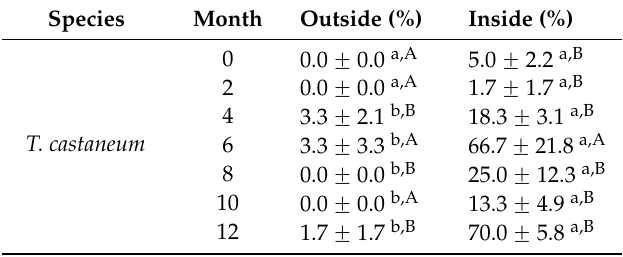
Table 1. Percentage (mean ˘ SE) of adult emergence of 4-week old larvae of T. castaneum and T. confusum exposed on the outside and inside surfaces of methoprene-treated bags (0.1% active ingredient). Bioassays were done every two months for 12 months. Emergence of morphologically normal adults in untreated controls of both species was above 95%, data eliminated from analysis 1